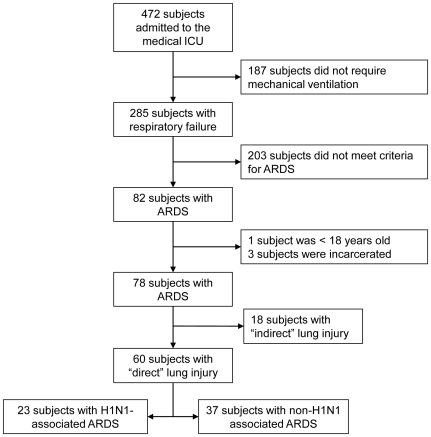
Cohort enrollment diagram.